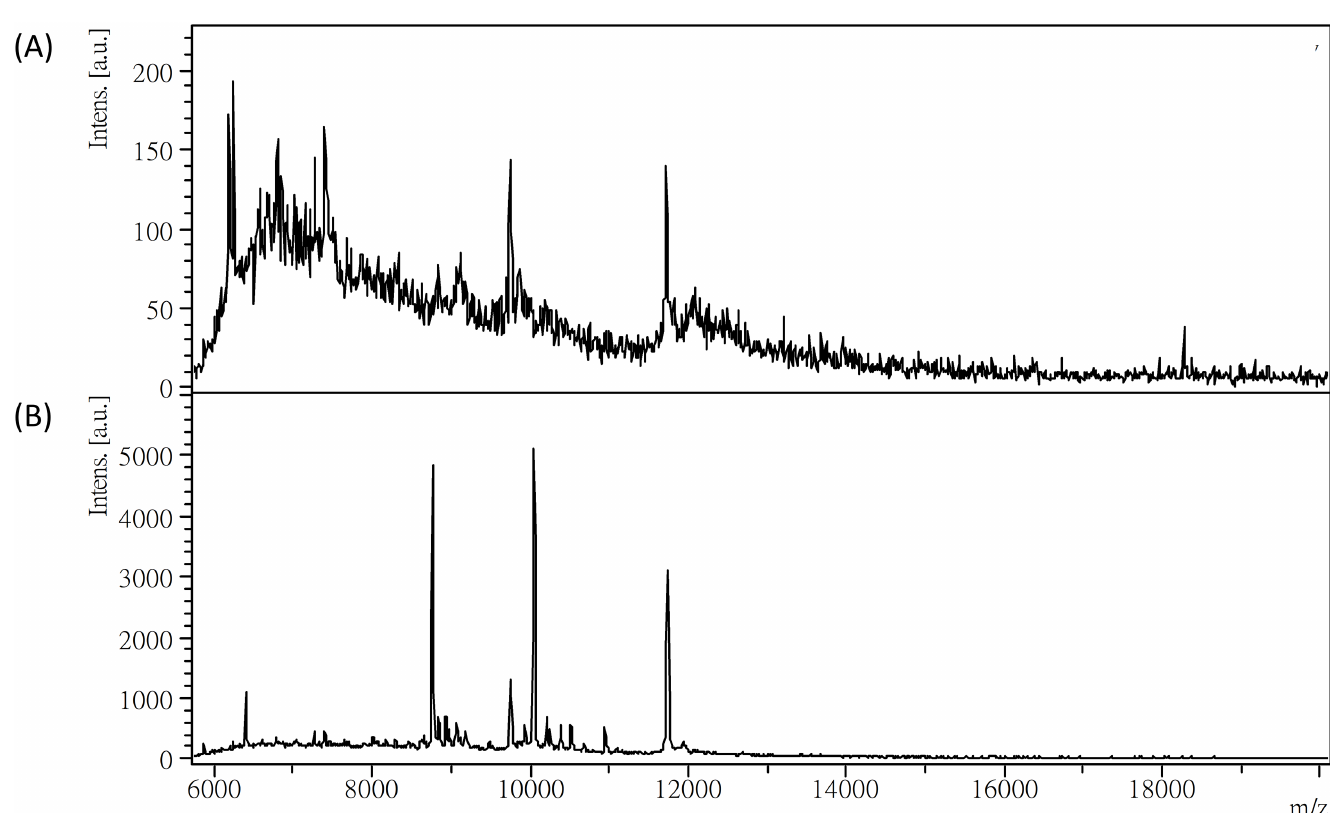
Fig 2. MALDI-TOF mass spectra of urine samples. (A) Without desalting. (B) With C 18 -plate desalting.